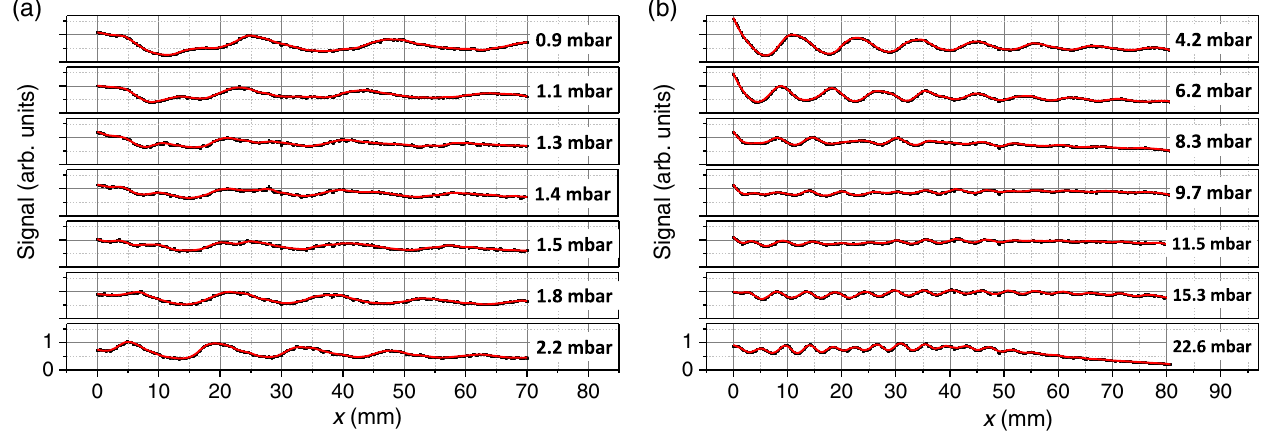
FIG. 12. Variations of the normalized fluorescence signal along the central jet line for different values of the pressure P the graphs. Red curves show Savitzky-Golay signal processing [71] of PLIF measurements data (black symbols). (a) Nozzle 1. P ∼ 325 mbar. (b) Nozzle 2. P ∼ 340 0 0